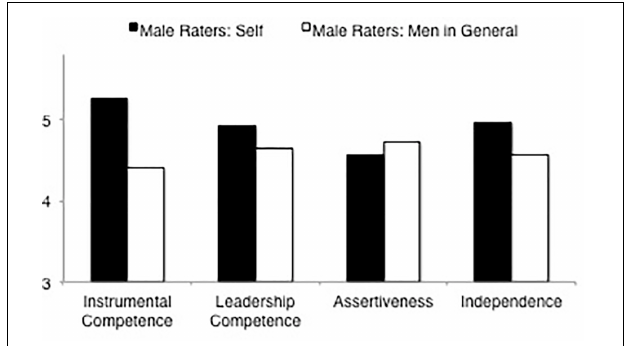
FIGURE 4 | Ratings of agency dimensions (instrumental competence, leadership competence, assertiveness, independence) by male raters rating self and men in